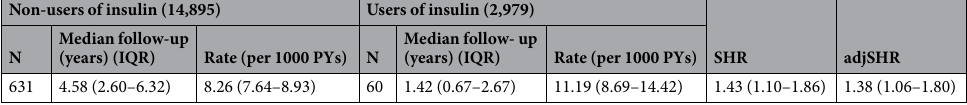
Table 2. Fracture incidence among matched users of any insulin (N = 2,979) and non-users of insulin (N = 14,895). Only the first continuous insulin use considered (switching types was accounted for), then censored. All analyses include incident insulin use as a time-dependent covariate. Analyses are PS matched at a 5:1 ratio of non-users to users. Adjusted analyses control for outstanding confounders (P < 0.1), i.e. BMI, steroids, meglitinides, and anti-hypertensive therapy. Abbreviations: N (number of fractures), Interquartile range (IQR), person-years (PYs), subhazard ratio (SHR), adjusted (adj).